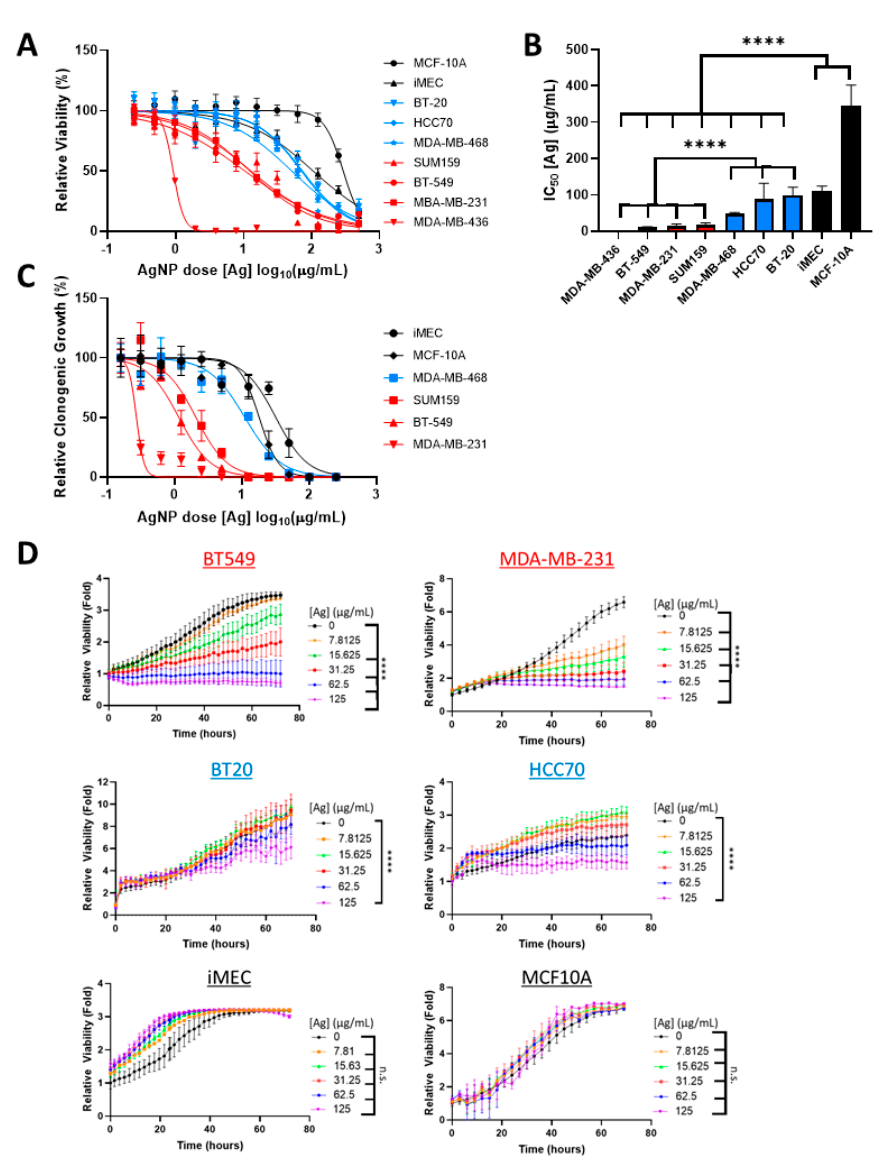
Figure 1. Claudin-low breast cancer (CLBC) cells are sensitive to low doses of silver nanoparticles (AgNPs), which do not affect basal-like breast cancer (BLBC) cells. ( A ) CLBC (red), BLBC (blue), and non-malignant (black) cells were treated with AgNPs for 72 h and viability was assessed by MTT assay. ( B ) IC 50 was calculated. Data were obtained from at least four biological replicates per dose and three independent experiments per cell line. Statistical analysis was performed by two-way ANOVA followed by post hoc Tukey test. Significant differences are indicated (**** p < 0.0001). ( C ) Clonogenic survival of CLBC (red), BLBC (blue), and non-malignant (black) cells was assessed after AgNP treatment. Data were obtained from three biological replicates per dose and are representative of duplicate independent experiments per cell line. ( D ) Proliferation was assessed by Incucyte time- lapse imaging of the indicated cell lines over 72 h with or without AgNPs. Data were obtained from at least four biological replicates per dose and are representative of three independent experiments per cell line. Statistical analysis was performed by two-way ANOVA followed by post hoc Tukey